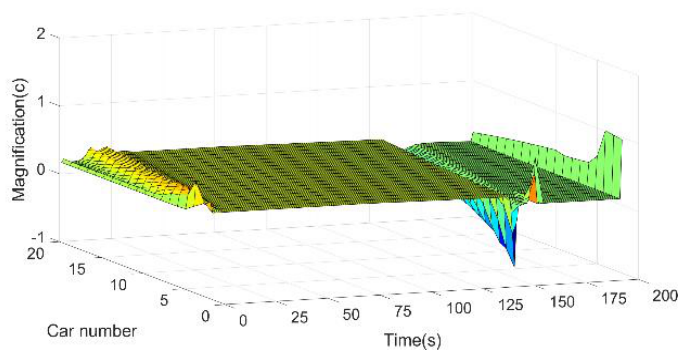
Figure 9. Vehicle current in driving situation 3.